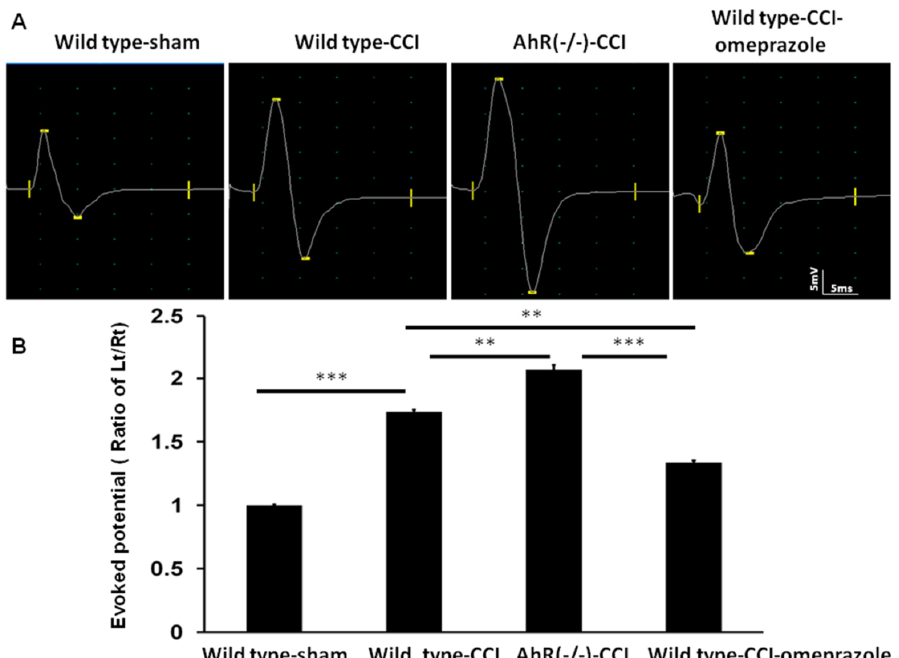
Figure 10. Alteration of somatosensory evoked potential in CCI in the different treatment groups. Either wild or AhR-deleted mouse received CCI injuries and then were subjected to omeprazole treatment. The somatosensory evoked potential was measured 28 days after CCI. ( A ) A representative of somatosensory evoked potential in the different treatment groups. ( B ) The quantitative analysis of the amplitude of evoked potential in the different groups. N = 6; Wild type-sham; Wild type-CCI; AhR ( − / − )-CCI; Wild type-CCI-omeprazole: see text. **: p < 0.01; ***: p < 0.001.